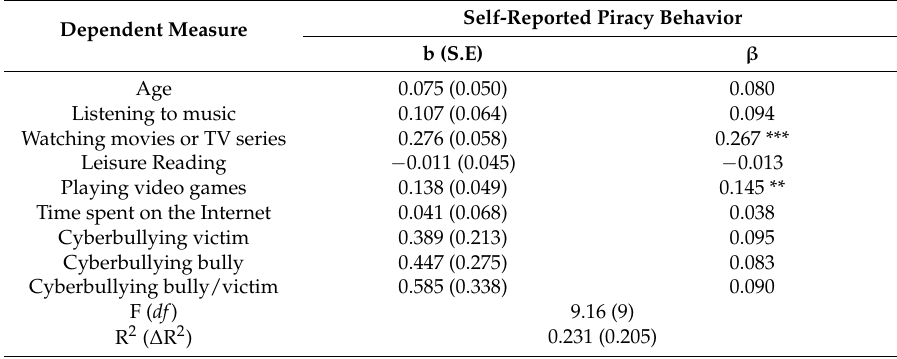
Regression analyses: associations of leisure activities, time spent on the Internet, and cyberbullying roles on self-reported piracy behavior for female